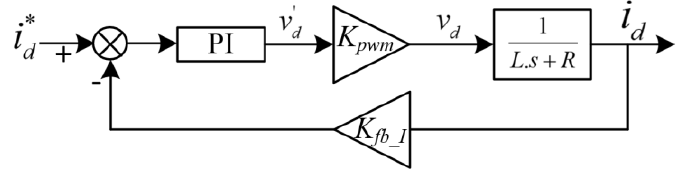
Figure 4. Current loop control design.